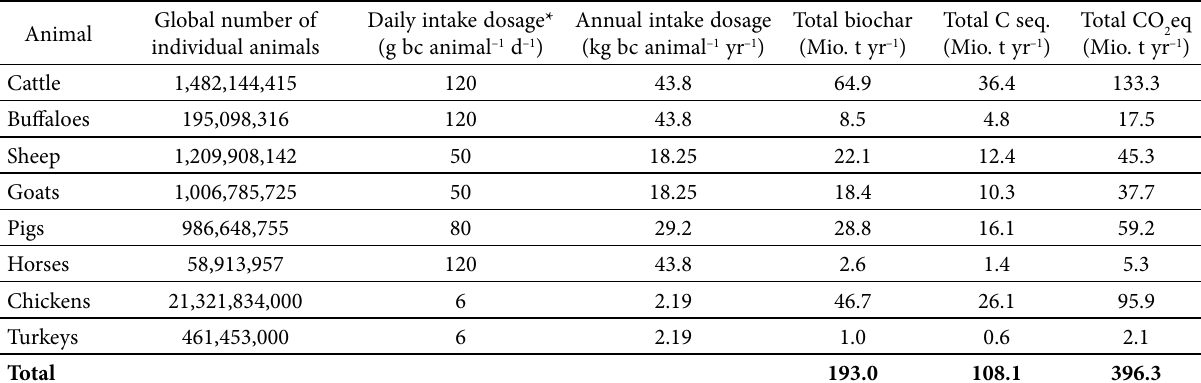
Table 1. Carbon sequestration potential of biochar fed to livestock (globally) with subsequent manure application to soil. Numbers of total livestock follow FAO statistics obtained for 2014 (FAO 2016). An intake dosage of 1% of the daily feed weight was assumed. The C sequestration potential was calculated with the assumption of 80% C in biochar, and 70% C persistence over 100